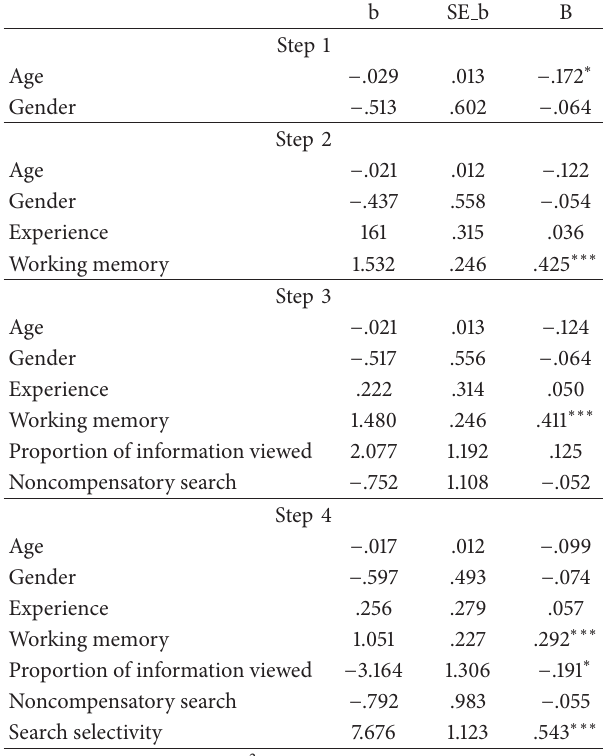
Table 3: Linear regression predicting decision quality (𝑛 = 176)